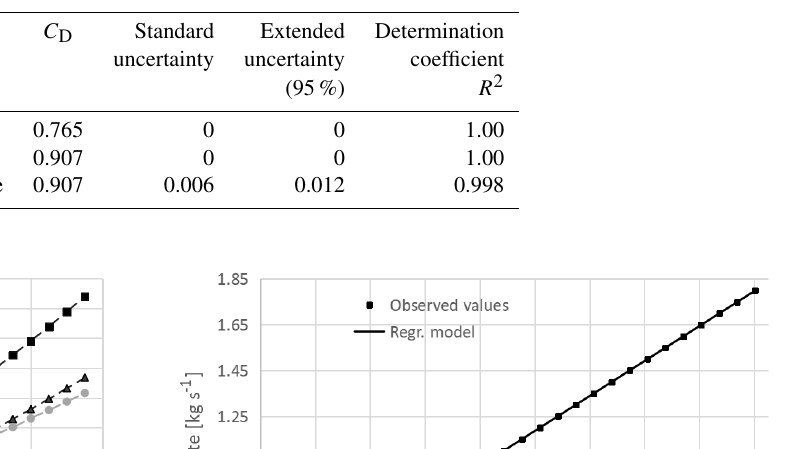
Table 5. Linear fit parameters.